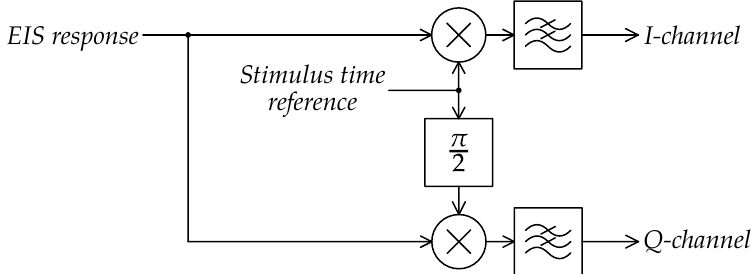
Figure 23. I/Q demodulation of the EIS